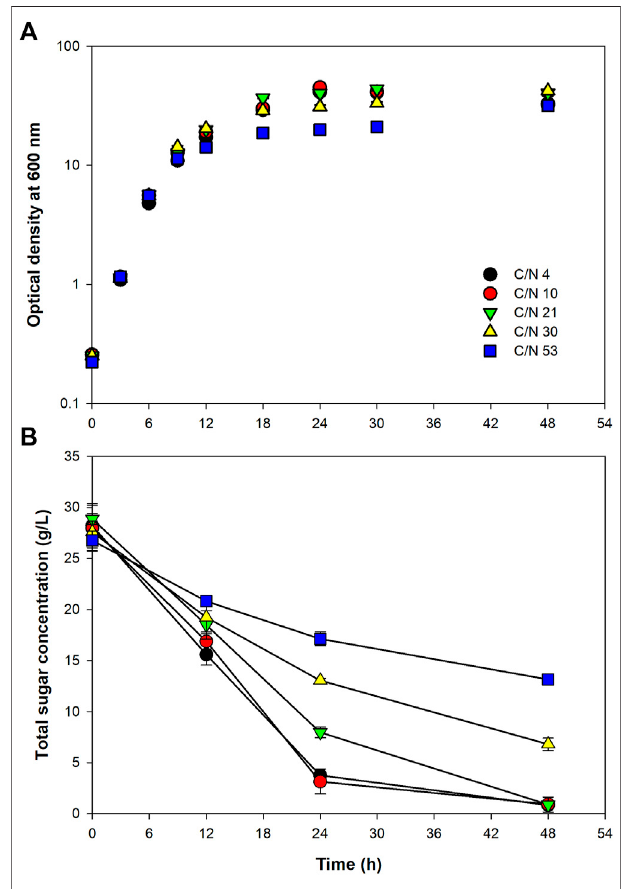
FIGURE 1 | Growth of Paracoccus sp. KKU01 on sugarcane juice- based medium (A) and total sugar consumption (B) at C/N ratios of 4 to